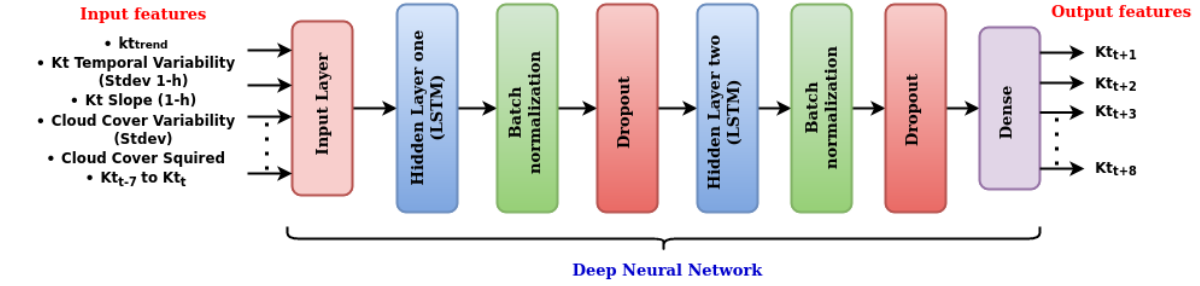
Figure 8. Network configuration of